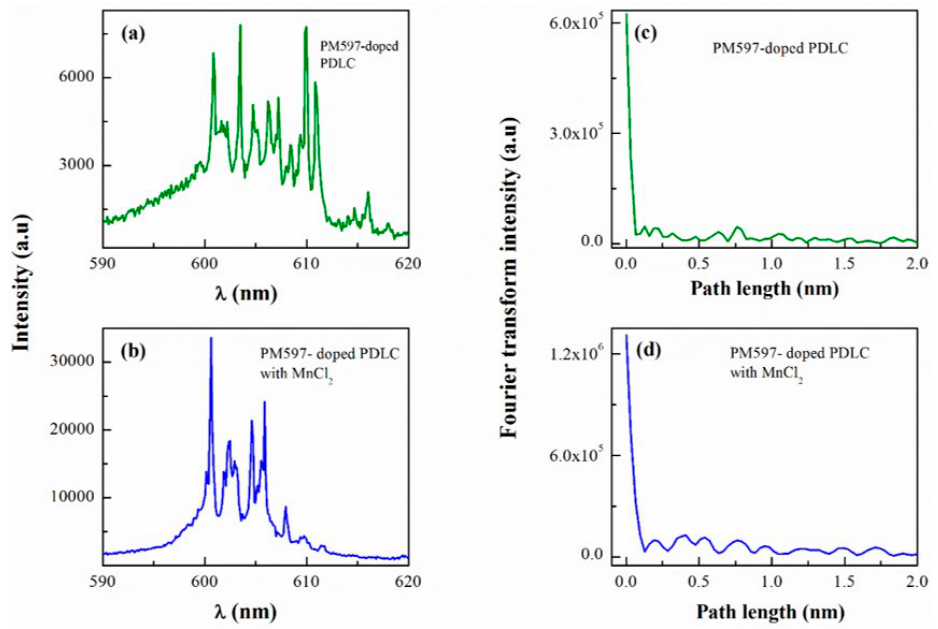
Figure 6. Emission spectra of ( a ) PM597-doped PDLC and ( b ) PM597-doped PDLC and MnCl 2 (0.1 mL) systems with pump energy 14.75 μ J and pumped area A ~ 0.06 mm 2 ; ( c , d ) The power Fourier transform (PFT) of corresponding emission spectra in Figure 6a,b.